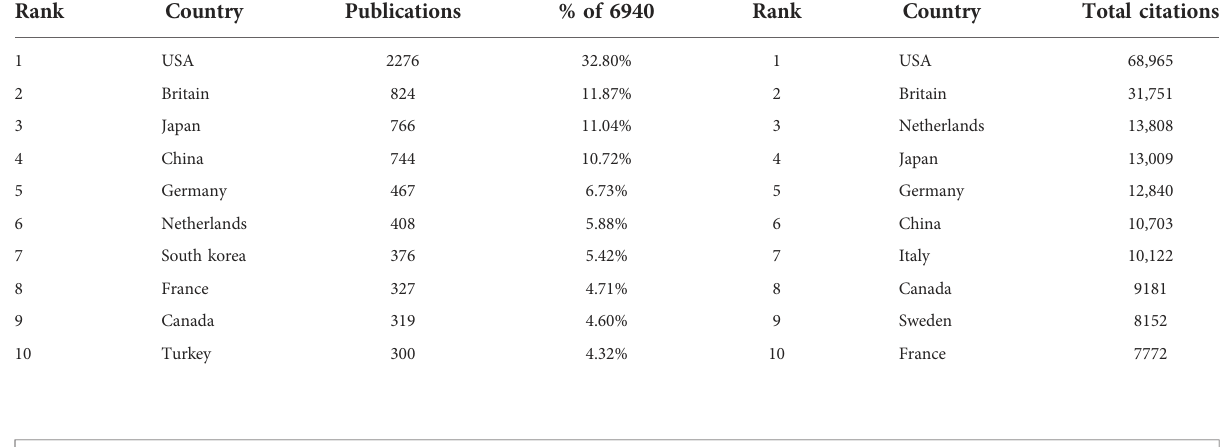
TABLE 1 Top 10 countrys publishing original human studies on the topic of overactive bladder. Rank Country